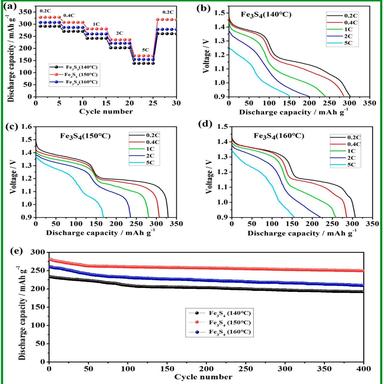
(a) Rate performance of the three Fe3S4 electrodes at various discharge rates (0.2–5 C); Typical discharge curves of the three Fe3S4 electrodes at various discharge rates: (b) 0.2 C, (c) 1 C, (d) 5 C; (e) Cyclic performance of the as-prepared three Fe3S4 electrodes at a charge/discharge rate of 1 C.